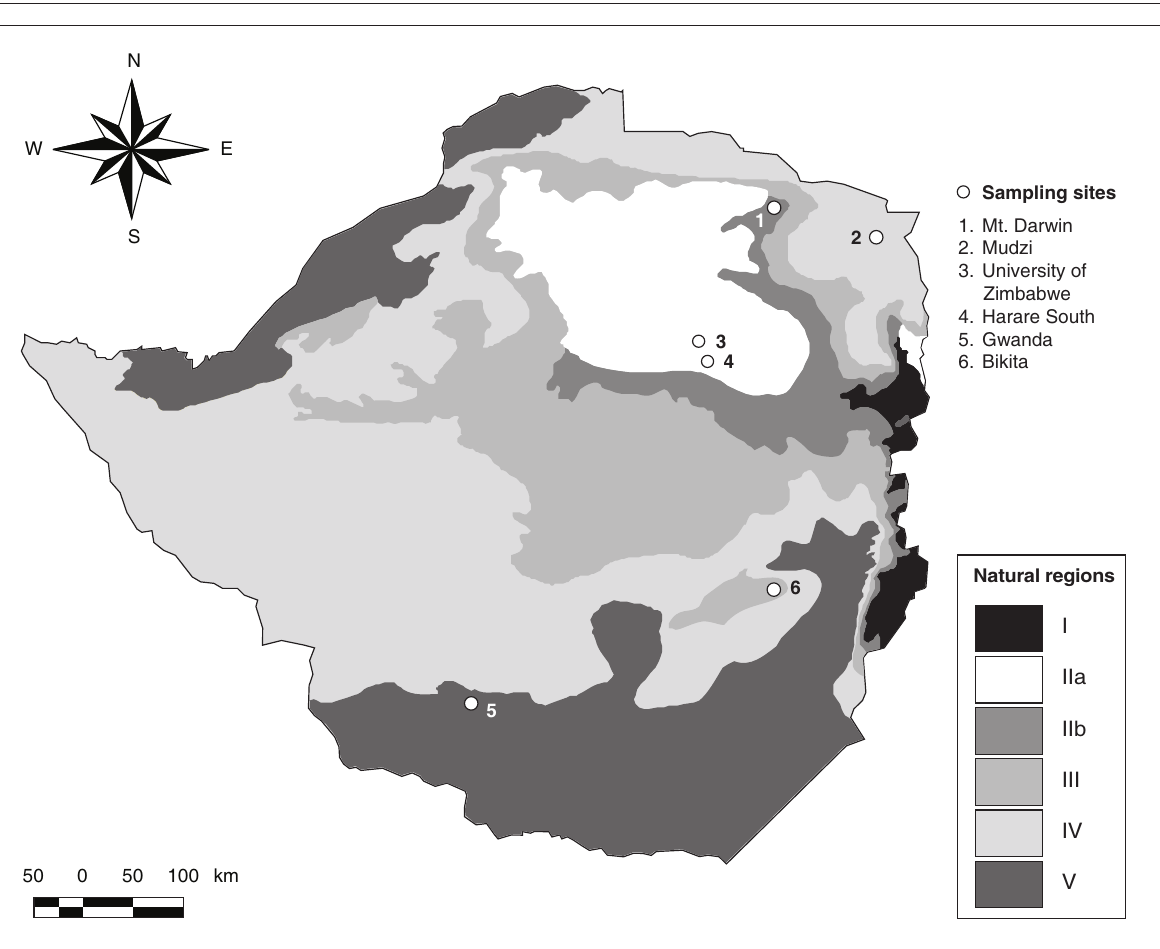
FIG. 1 Map of Zimbabwe showing the centres of the districts from where the sheep and goats sampled